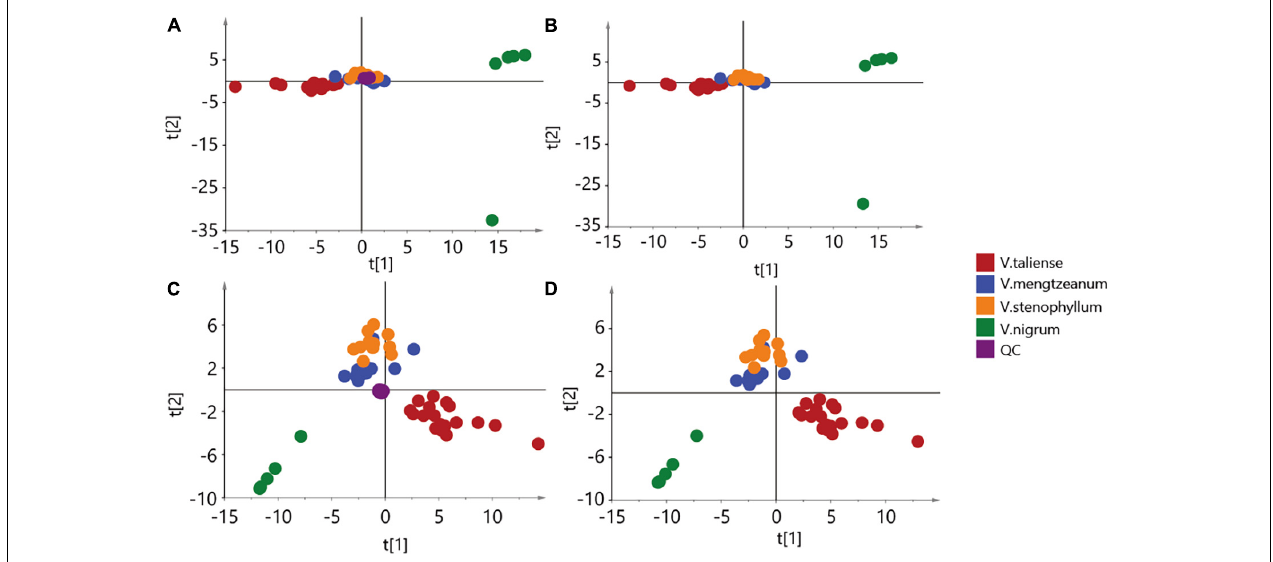
FIGURE 3 | Principal component analysis (PCA) score plot. (A,B) The aggregation of 147 variables. (C,D) The aggregation of 97 variables, after clearing by the “80% rule”.